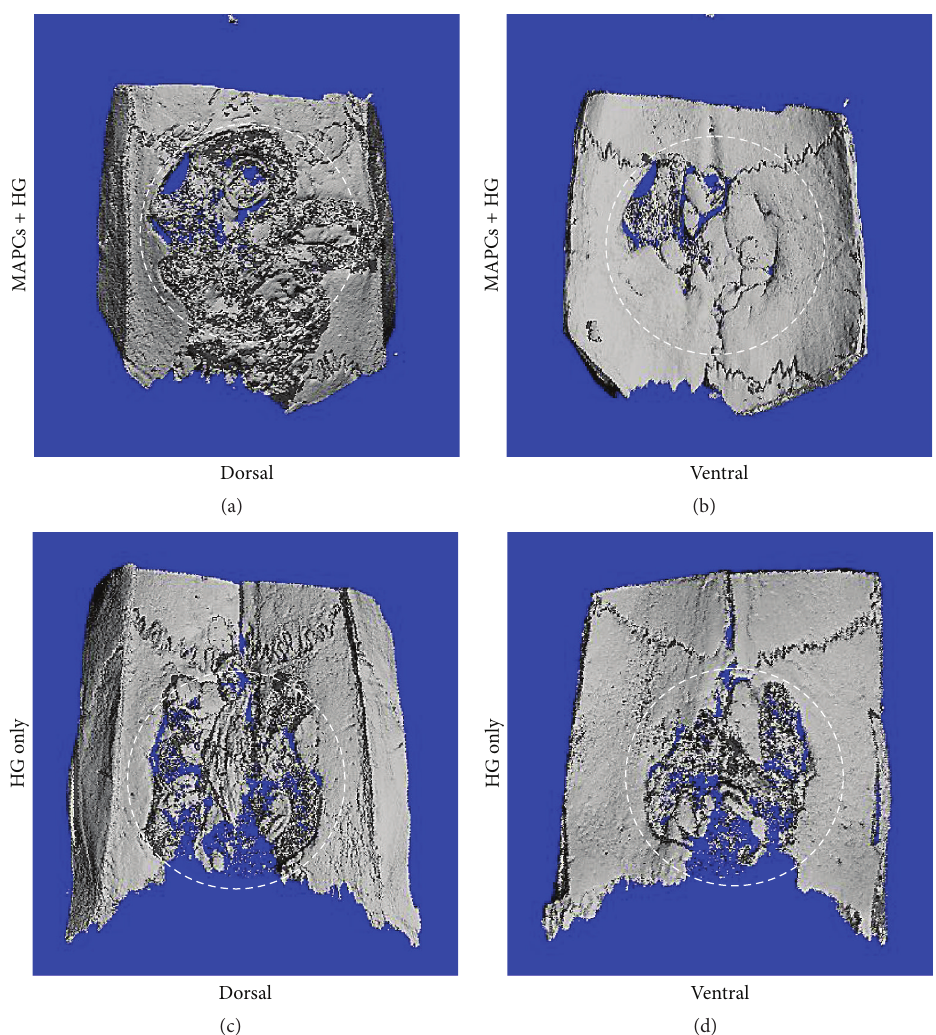
Figure 4: Micro-CT images of critical-sized calvarial defects after 12 weeks of implantation. White dotted circle represents defect site (8mm in diameter). MAPCs with HG group ((a) and (b)) and HG-only group ((c) and